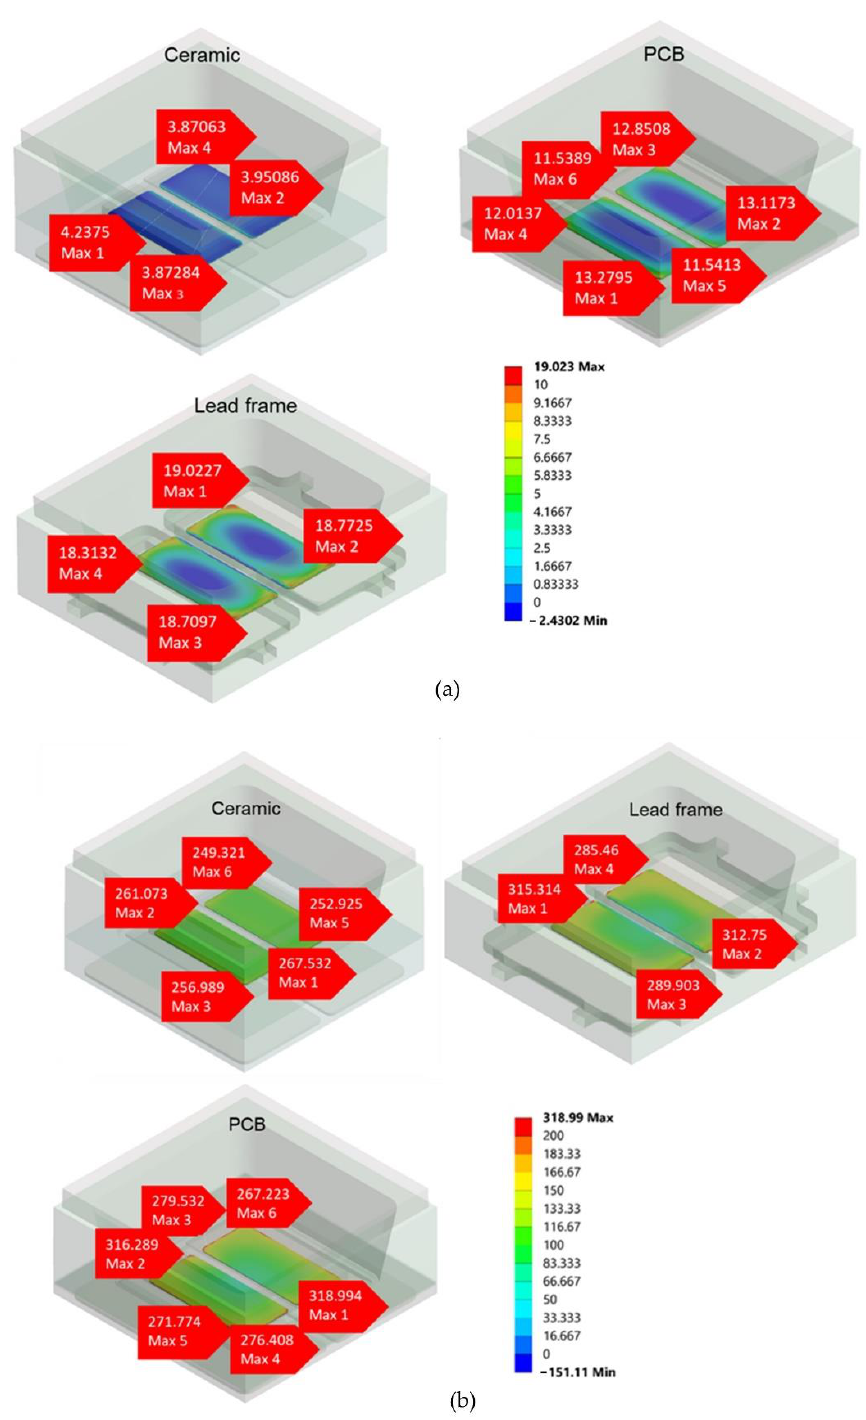
Figure 8. The 3D image of the stress value at the die-attached (DA) area for three types of VCSEL packages during mechanical stress simulation at ( a ) high temperature of 260 °C and ( b ) low temperature of − 40 °C.